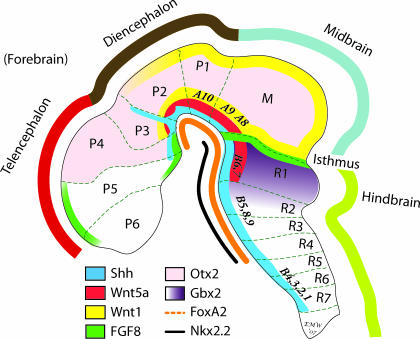
Factors influencing monoaminergic cell development in regions of FoxA2 expressionSchematic of brain, approximately E8-11. At earlier stages (not shown), Lmx1b, Wnt1, Grg4, Otx2, and Gbx2 set up complex parallel feedback loops that establish the FGF8 secreting isthmus organizer at the midbrain–hindbrain boundary. Shown here, at later stages, Otx2 represses Nkx2.2 expression in the mesodiencephalon. Shh, which is produced by cells of the floor plate and notochord, induces FoxA2 expression in the rhombencephalon (hindbrain), mesencephalon (midbrain), and caudal prosencephalon (dielcephalon). DA neurons are formed in those regions of FoxA2 expression where Nkx2.2 is repressed. Nine groups of dopaminergic neurons are formed in the forebrain and midbrain. Only groups A8–10 are shown. A8/9 cells give rise to the SN, whereas A10 cells eventually comprise the ventral tegmental area (VTN). Prosomeres, P1–P6; rhombmeres, R1–R7; serotonergic cells, B1–B9; DA cells, A8–A10. Figure is adapted from [8,19–21]